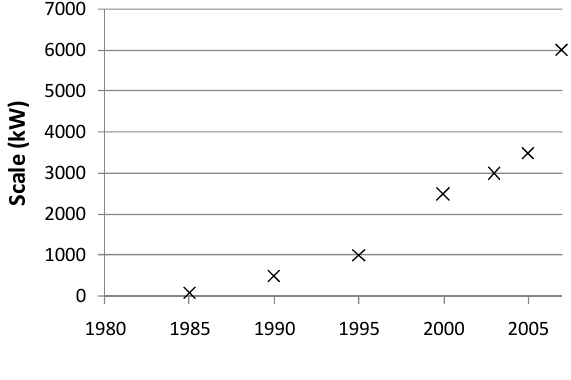
Figure 51. Maximum scale of wind energy converters over time (compiled after [228], [198] and